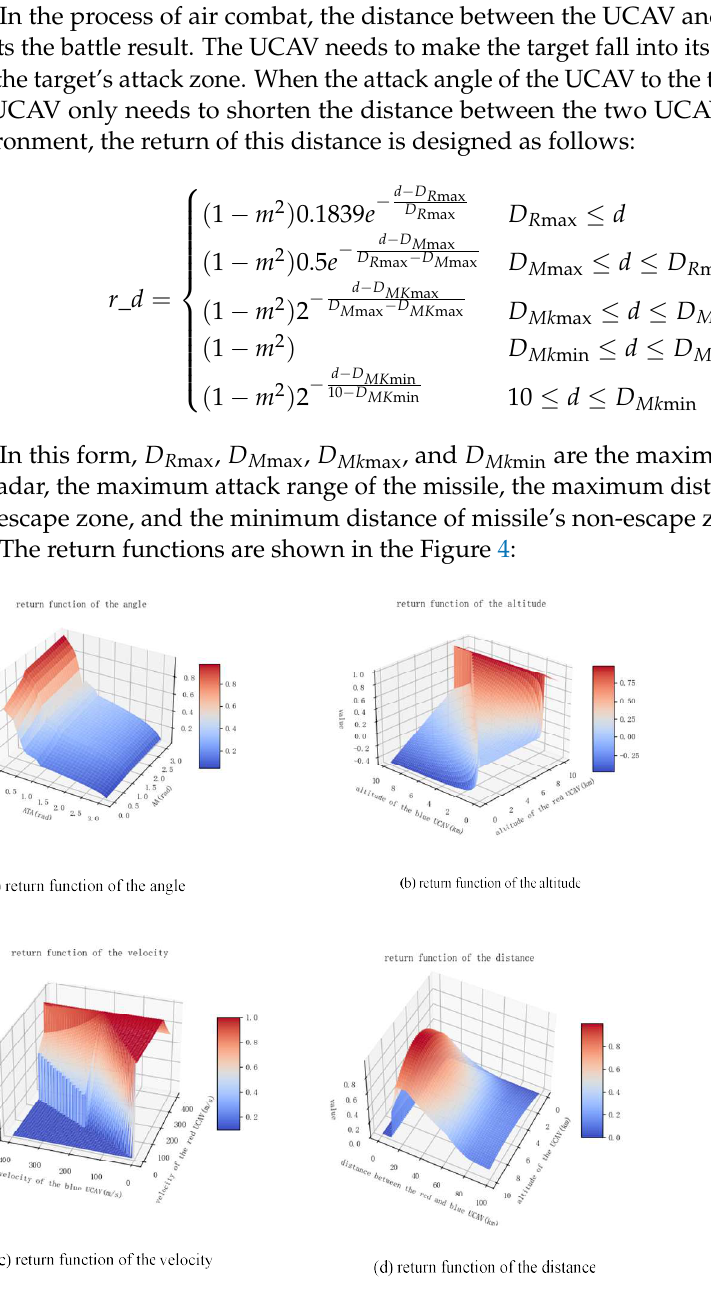
Figure 4. Return